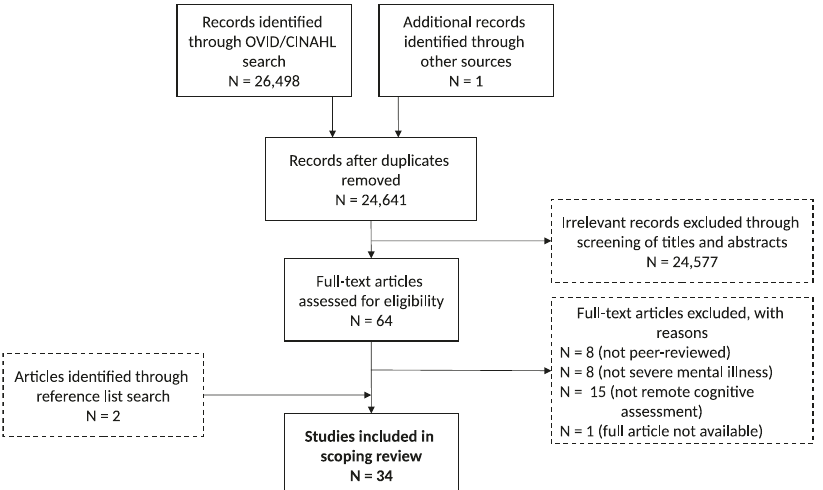
Fig. 1 PRISMA fl ow diagram of article selection and reasons for exclusion. Numbers from the three searches (May 11, 2020, November 11, 2020, and February 4, 2021) are combined in this fi gure but described separately in the main text. N number of